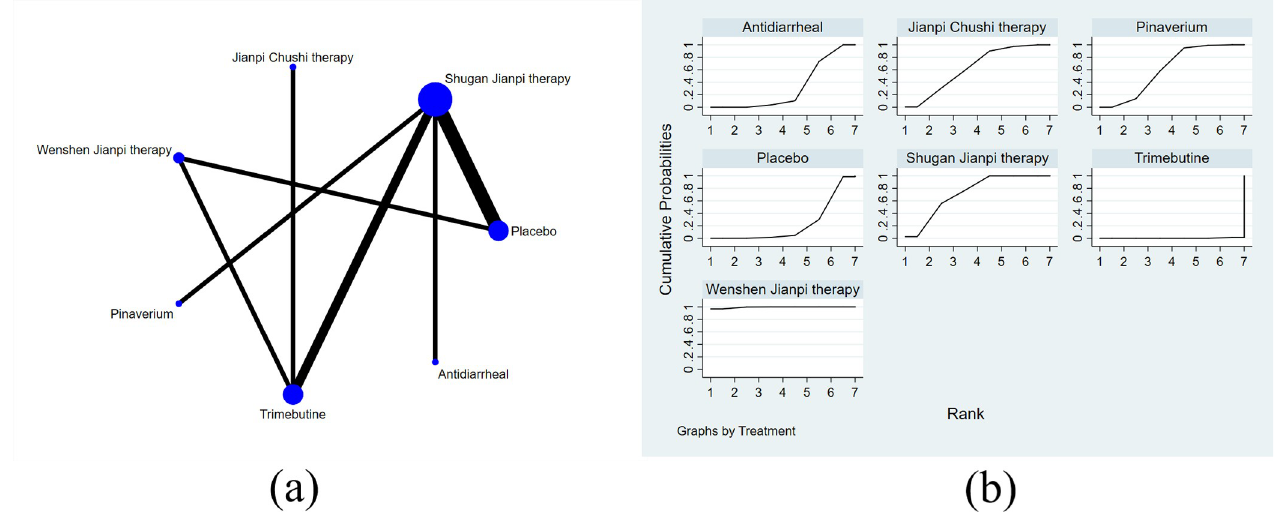
Fig 7. Network meta-analysis of IBS-severity scoring system: (a) Network evidence plot; (b) Surface under the cumulative ranking curve plot.